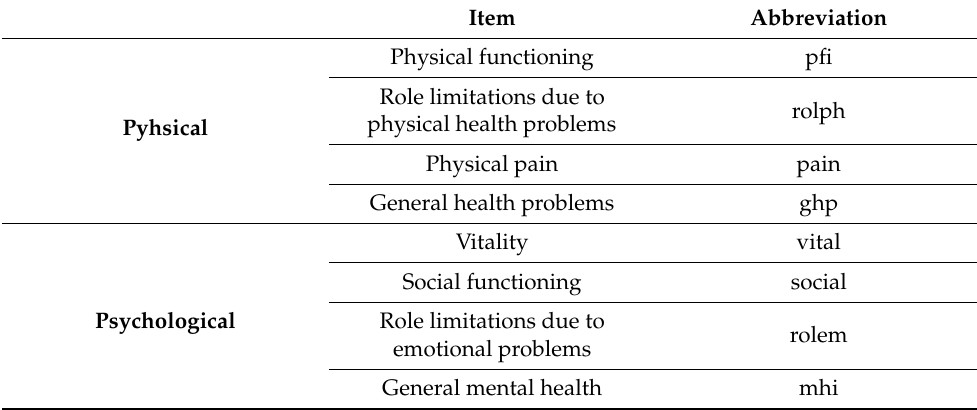
Table 1. The items of SF-36 questionnaire.